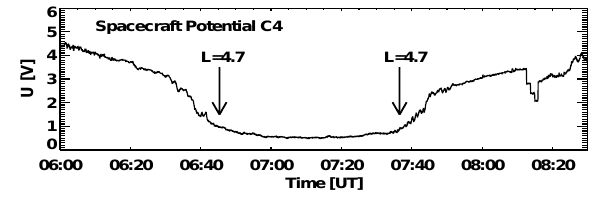
Fig. 2. Spacecraft potential U detected by Cluster C4. The arrows mark the times when spacecraft C4 crosses the assumed plasma- pause position at L = 4 . 7 (06:45 and 07:37